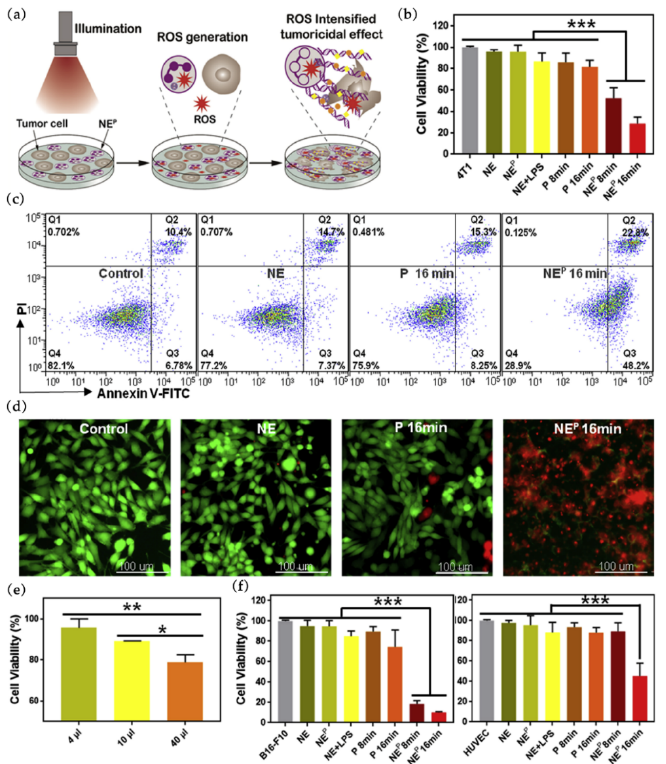
Figure 8. The enhanced TKA of NE P by photo-activated ROS generation and NETosis. ( a ) The under- lying tumoricidal mechanism of NE P . TKA assessment to 4T1 tumor cells via CCK8; ( b ) apoptosis assay; ( c ) the viability/cytotoxicity assay; ( d , e ) TKA assessment of NE + LPS group to 4T1 tumor cells via CCK8 with different LPS amount; ( f ) TKA assessment to B16-F10 tumor cells and HUVEC via CCK8. (* p < 0.05, ** p < 0.01, *** p < 0.001). Reprinted with permission from Ref. [49].